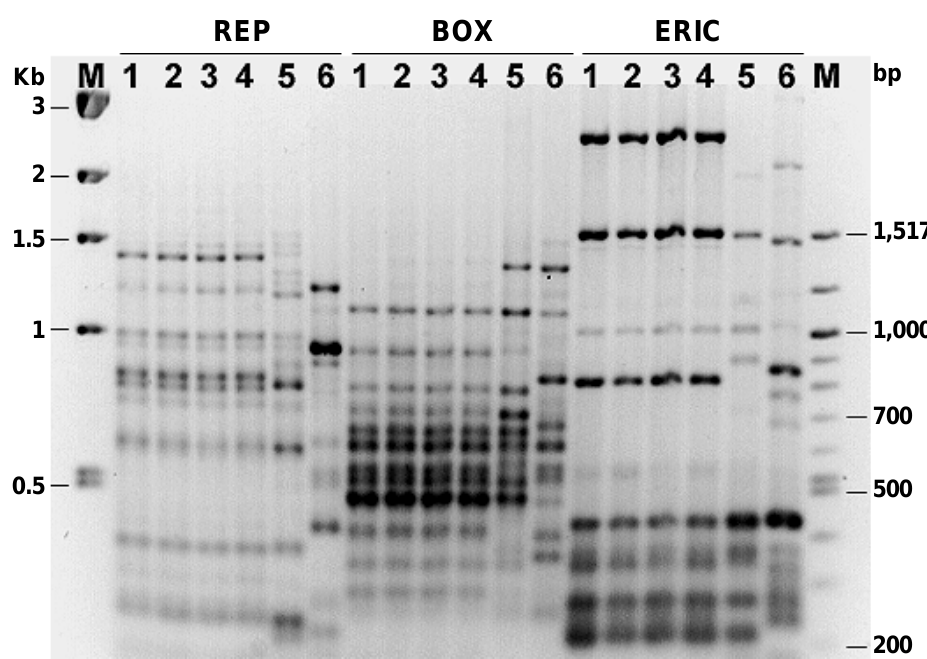
Fig. 2. Agarose gel electrophoresis of polymerase chain reaction fingerprint patterns obtained from 3 bacterial isolates (lanes 1, 2 and 3) and 1 re-isolate (lane 4) from callas and from the strains LMG 2408 (lane 5) and NCPPB 2577 (lane 6) of Pectobacterium carotovorum subsp. carotovorum . The 35-40 bp repetitive extragenic palindromic (REP) sequence, the 154 bp BOX element and the 124-127 bp enterobacterial repetitive intergenic consensus (ERIC) sequence were used as primers in rep-PCR. M , 1 Kb ladder; M , 100 bp 1 2